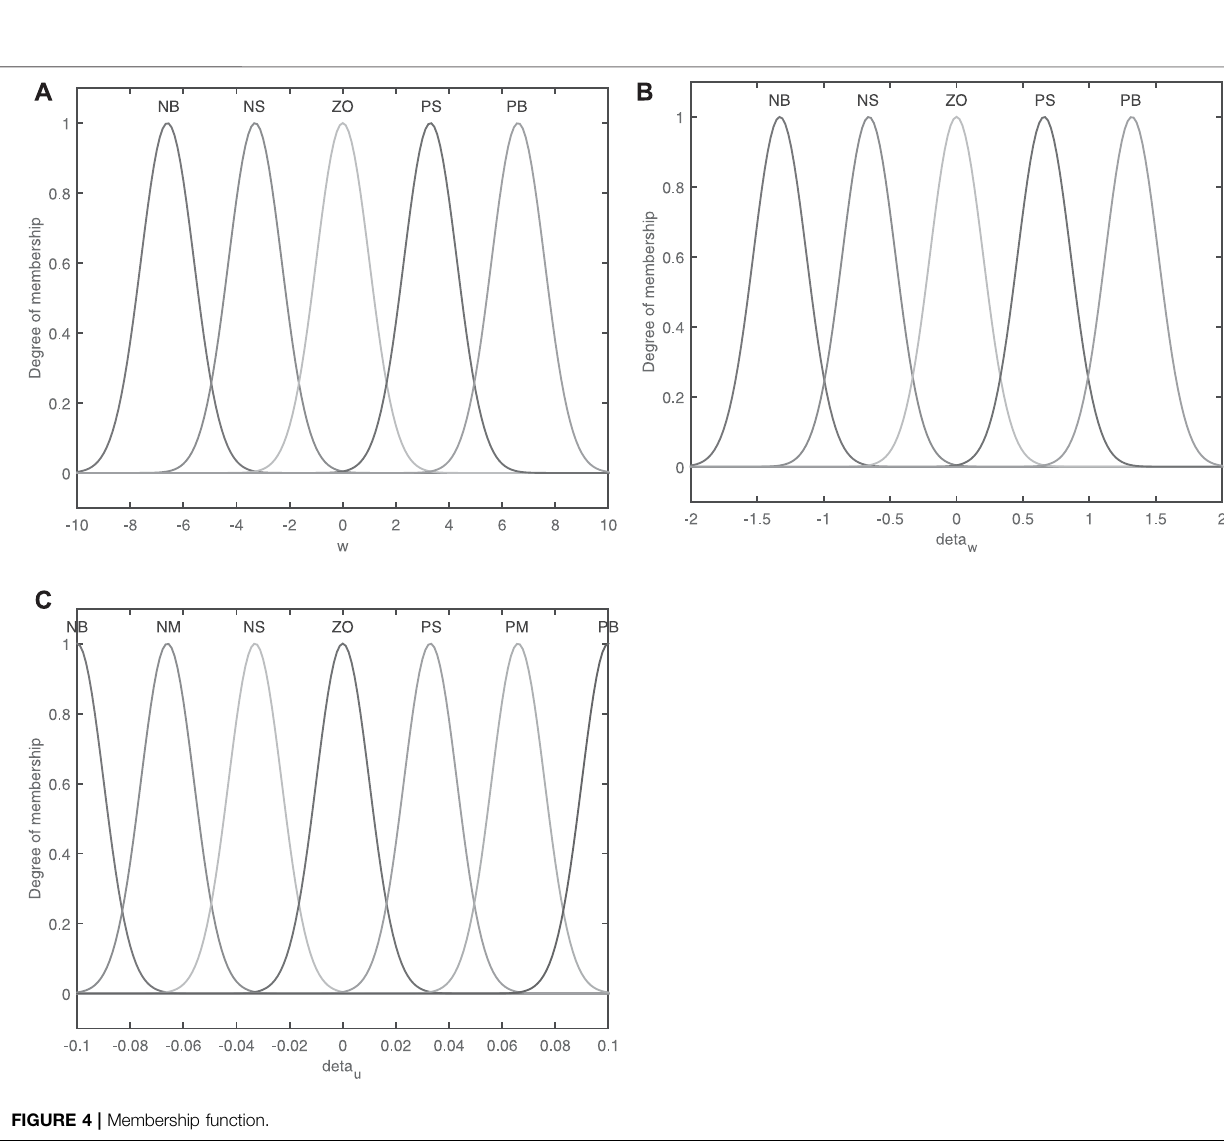
FIGURE 3 | Adaptive adjustment of forgetting factor based on Fuzzy Algorithm.